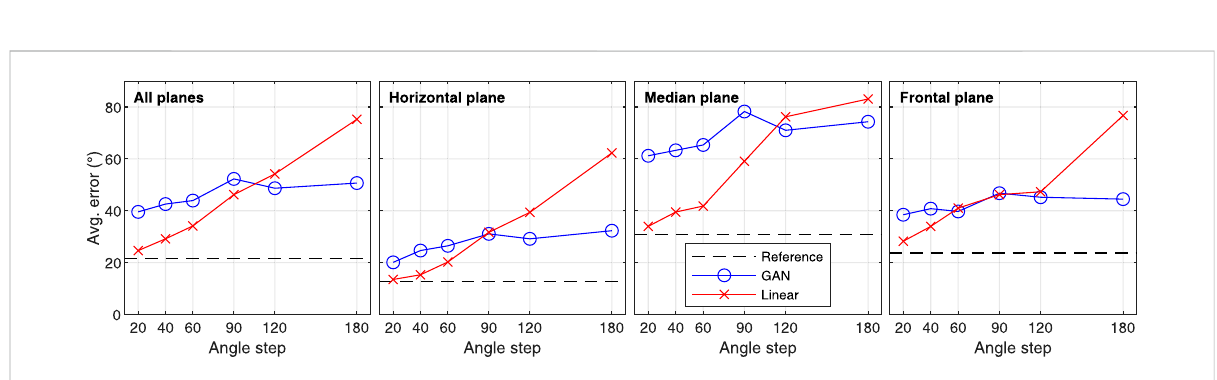
FIGURE 4 Average localisation error, as predicted by the model by Barumerli et al. (2020) (lower is better). The dashed line represents the ideal case of a real listener ’ s performance when localising a sound source with their own